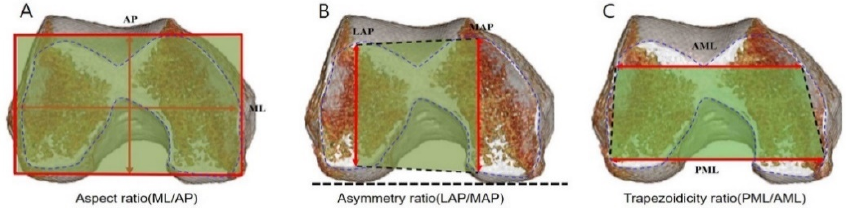
Figure 2. Three geometric ratios describe the morphology of bone after distal femur cutting: ( A ) aspect ratio (ML/AP), ( B ) asymmetry ratio (LAP/MAP), and ( C ) trapezoidicity ratio (PML/AML). The maximum medial AP perpendicular to the line connecting the medial condyle and the posterior margin of the medial and lateral condyles was taken as medial anteroposterior (MAP). The maximum lateral AP was lateral anteroposterior (LAP). The larger of the two values was set to the AP value. The posterior medial-lateral (PML) width was the posterior femoral condylar cutting width and the anterior medial-lateral (AML) width was measured at 75% AP.